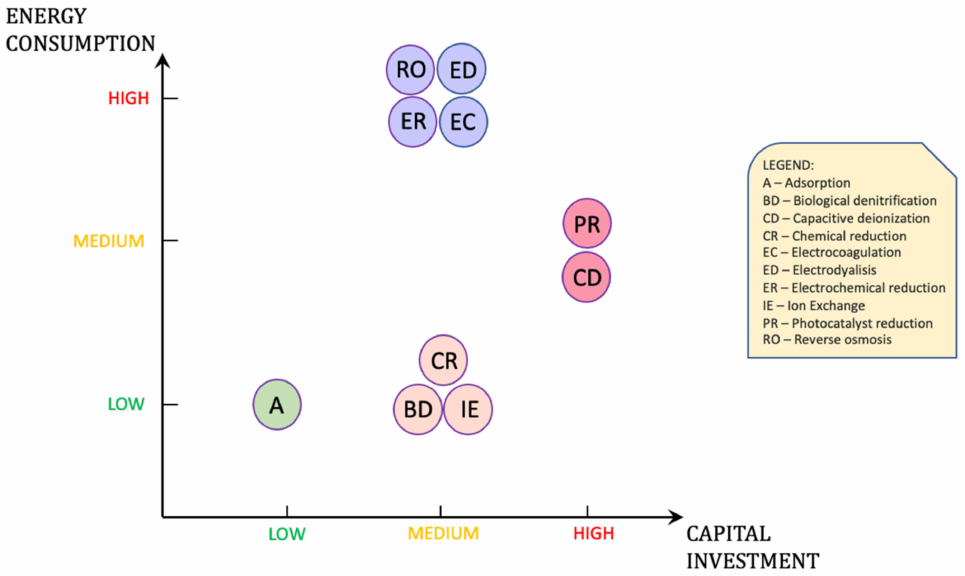
Figure 11. Categorisation of nitrate removal technologies according to capital investment and energy